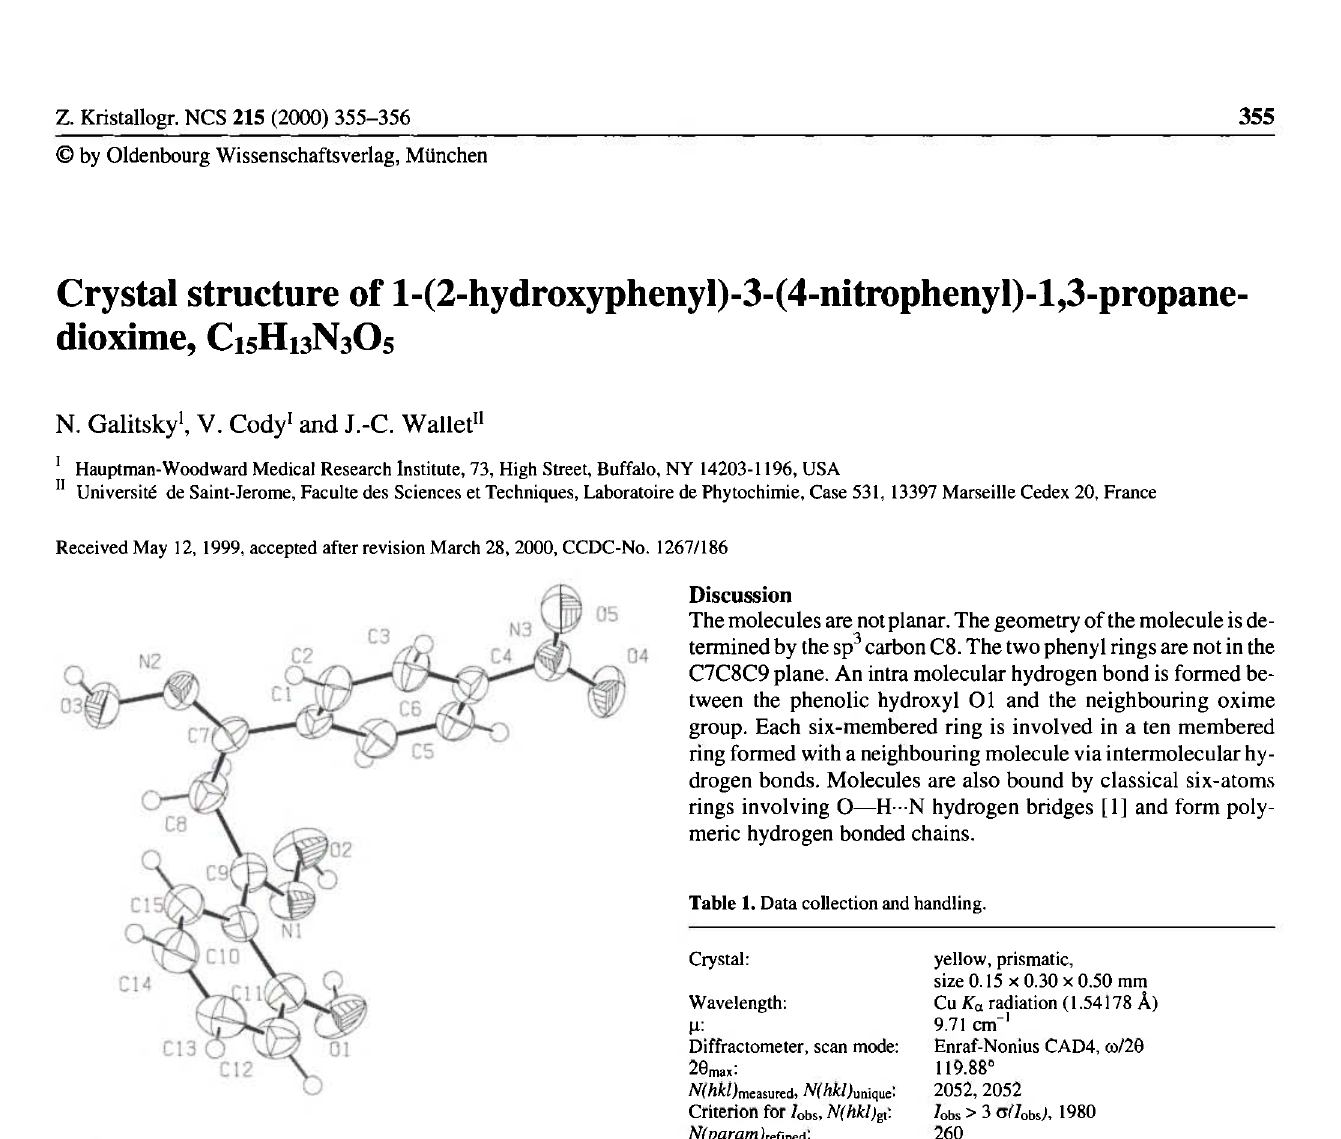
Table 1. Data collection and handling.